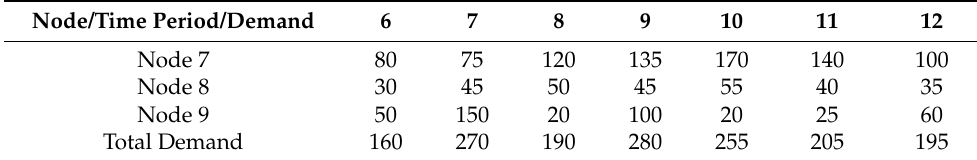
Table 5. RFQ for all customers in basic scenario.